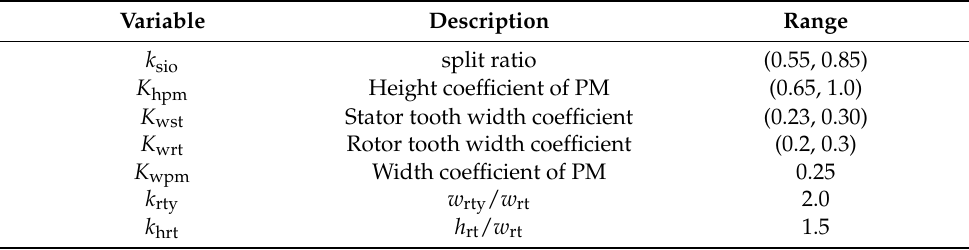
Table 3. Initial intermediate parameters of the FSPM generator.